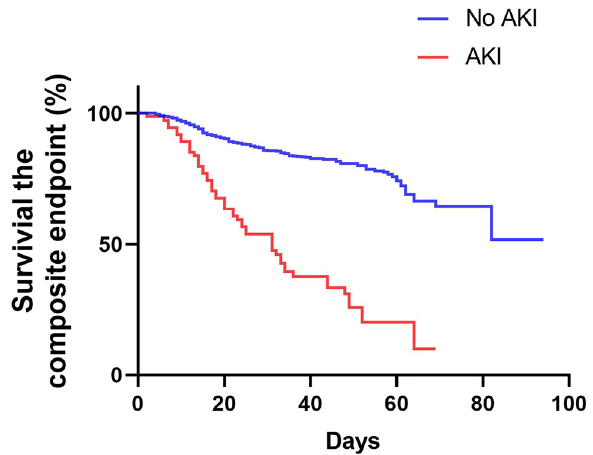
Figure 2. Kaplan–Meier survival curves for the composite endpoint among COVID-19 patients with and without AKI. COVID-19, coronavirus disease 2019; AKI, acute kidney injury.